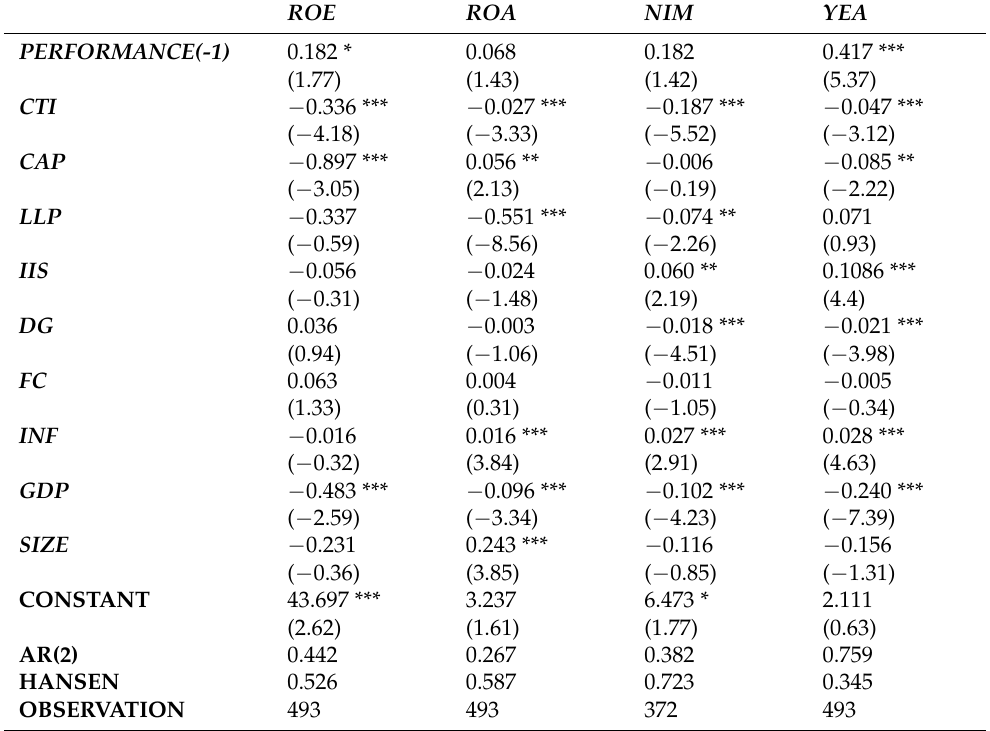
Table 4. Determinants of bank performance of Digital